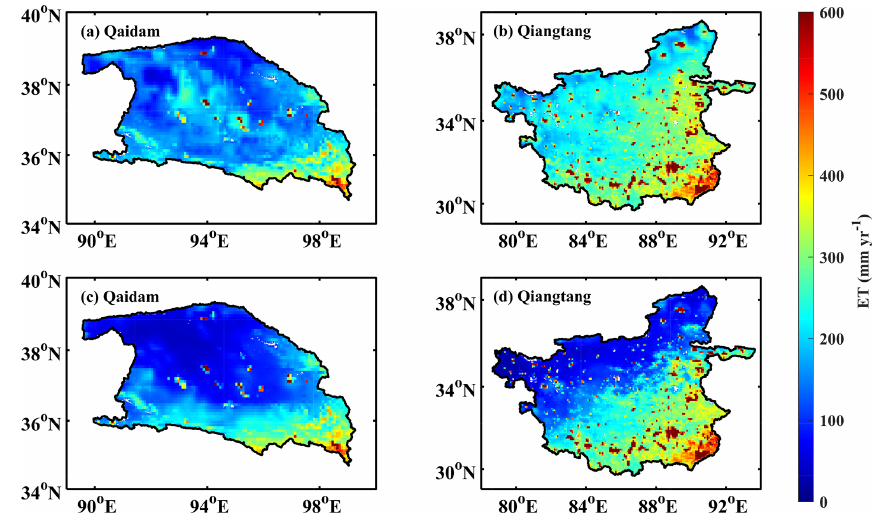
Figure 8. The spatial distributions of multi-year (January 2003–August 2011) average annual ET derived from (a, b) the P-LSH θ and (c, d) P-LSH P for (a, c) the Qaidam Basin and (b, d) the Qiangtang Plateau.